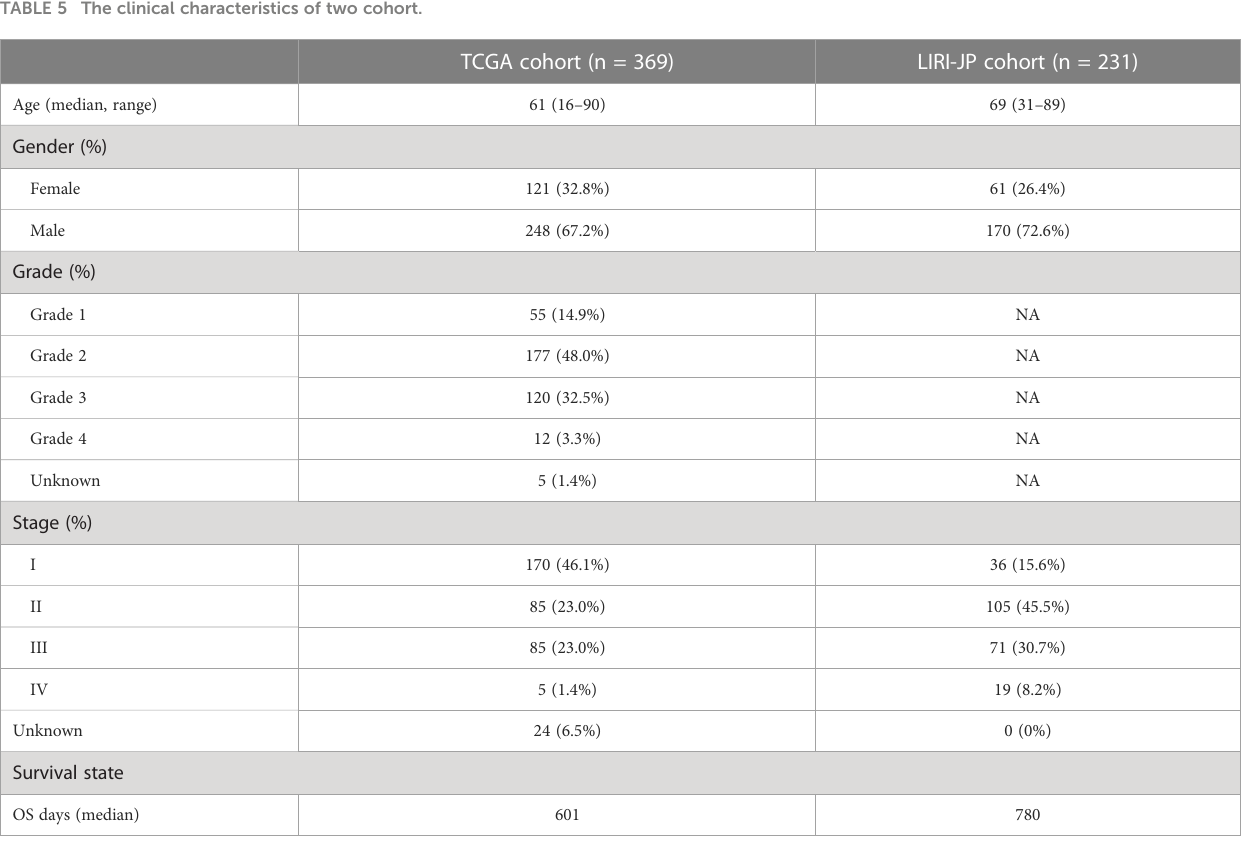
TABLE 5 The clinical characteristics of two